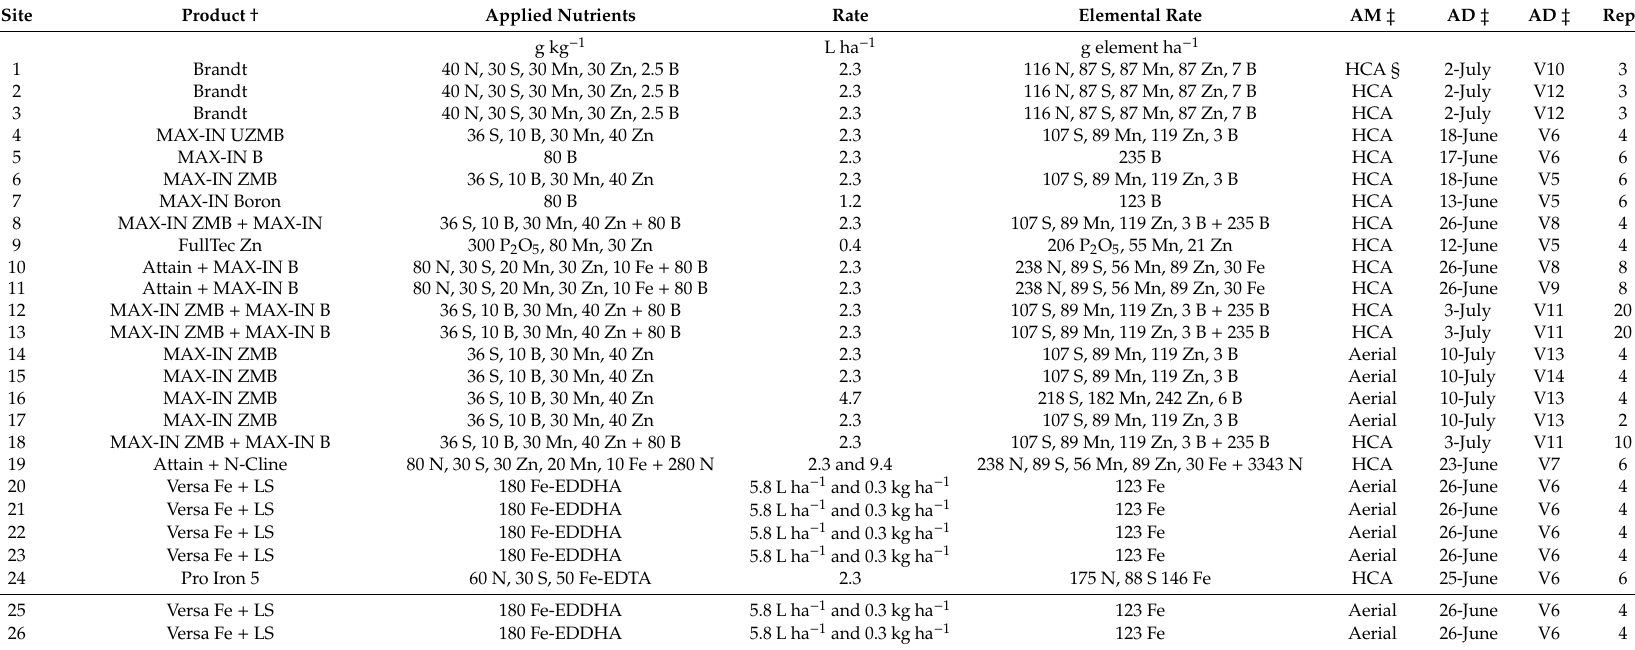
Table 2. Treatment micronutrient formulation and application background information for each of the 26